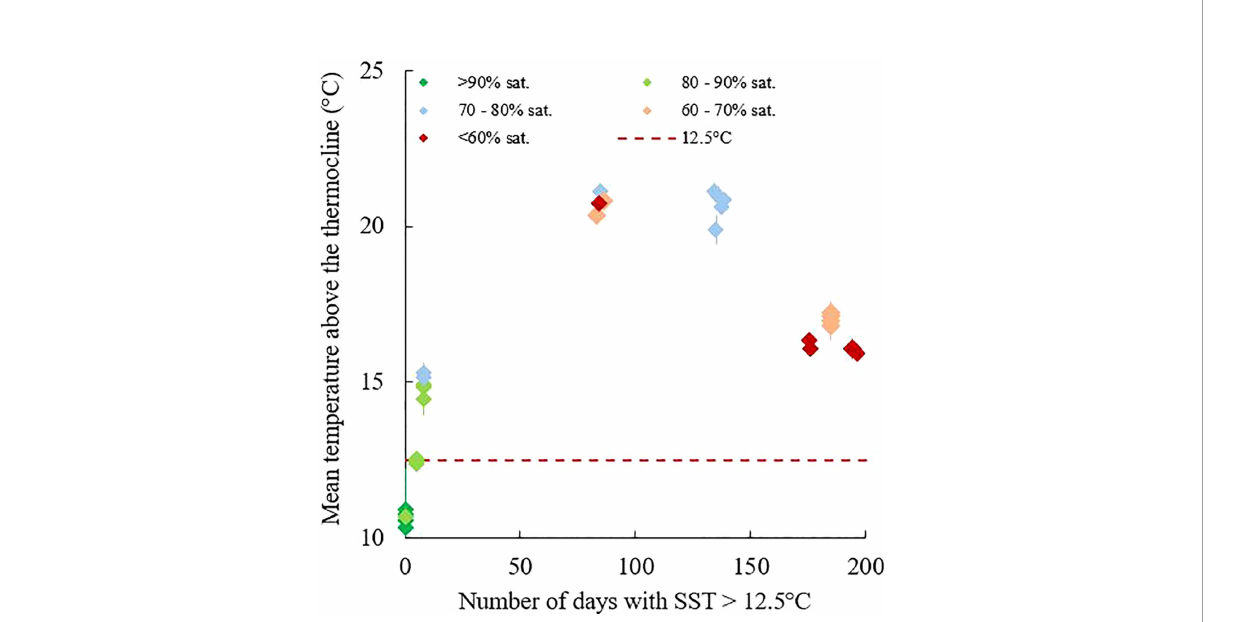
FIGURE 4 Relationships of the mean temperature above the thermocline, the duration of the thermal strati fi cation (number of days with SST > 12.5°C) and the dissolved oxygen saturations of bottom waters in the water column of the continental shelf off the Gironde for each cruise and stations 1, 2, 3, 8 and 4. Dissolved oxygen saturations were average over the 5 meters above the